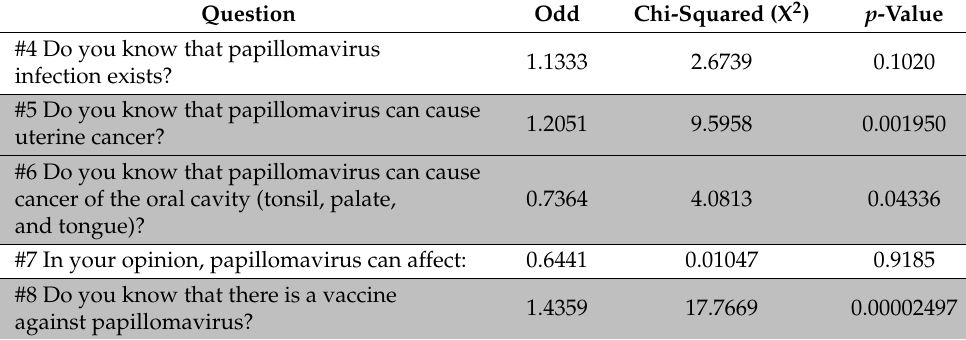
Table 2. Logistic regression